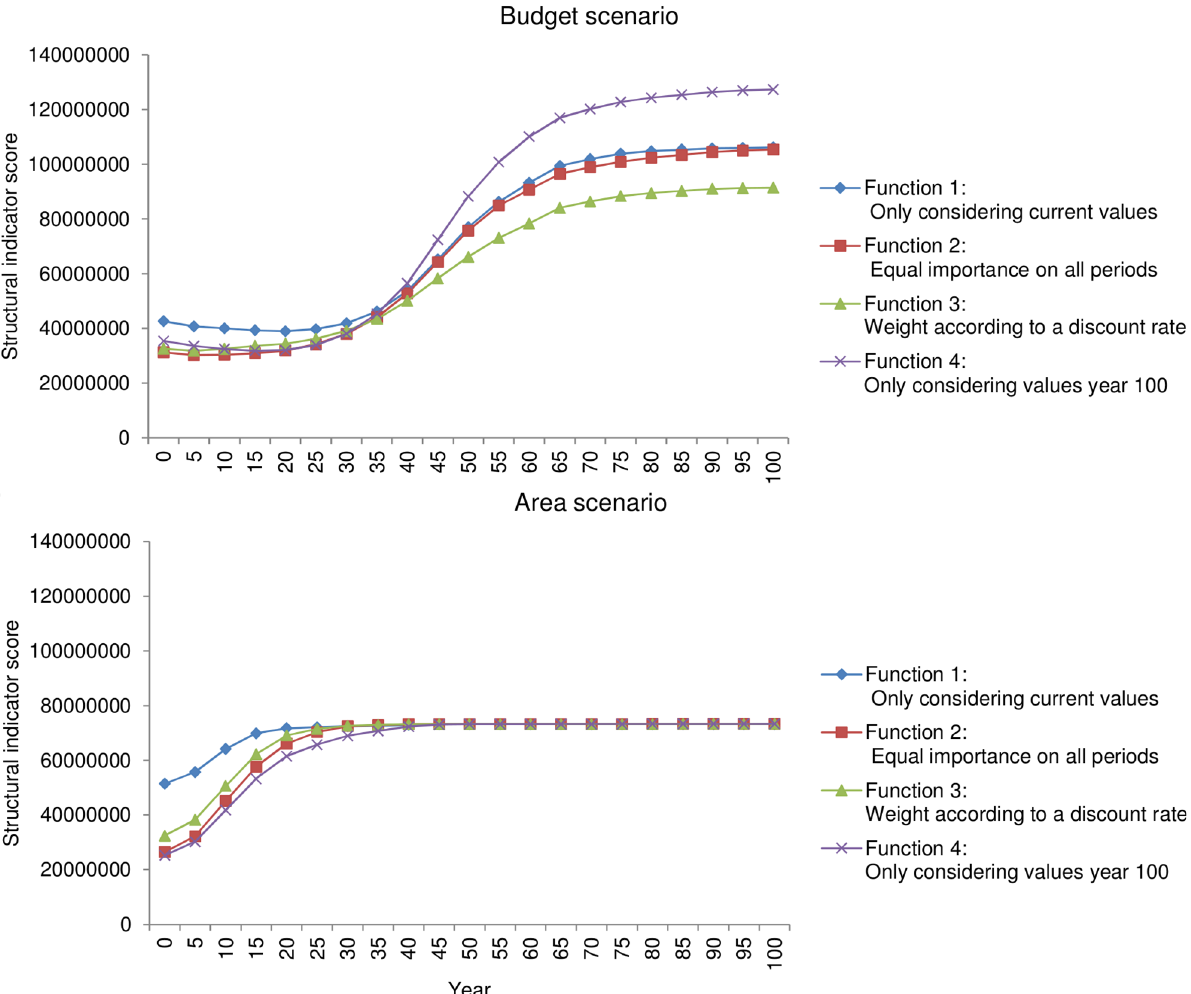
Fig 1. Changes with time of the structural indicator score per period over 100 years in (a) the budget-constrained selections and (b) the area- constrained selections for each of the four variants of the discount function, year 0 is the initial state based on NFI data inventoried between 2003 and